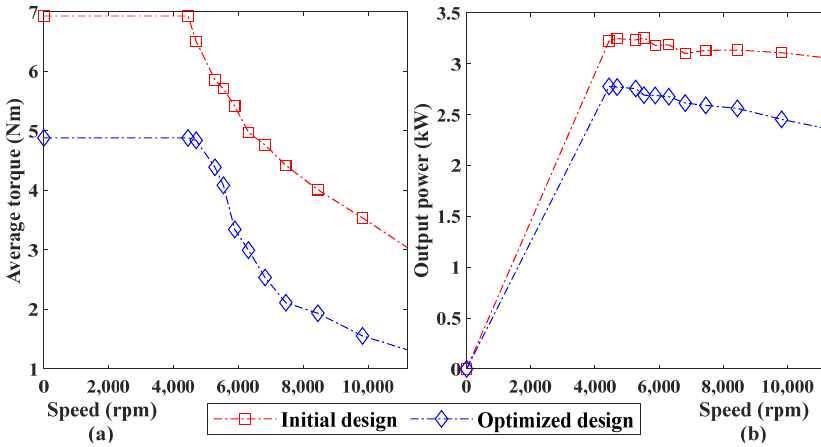
Figure 17. ( a ) Torque vs speed curve; ( b ) power vs speed curve.